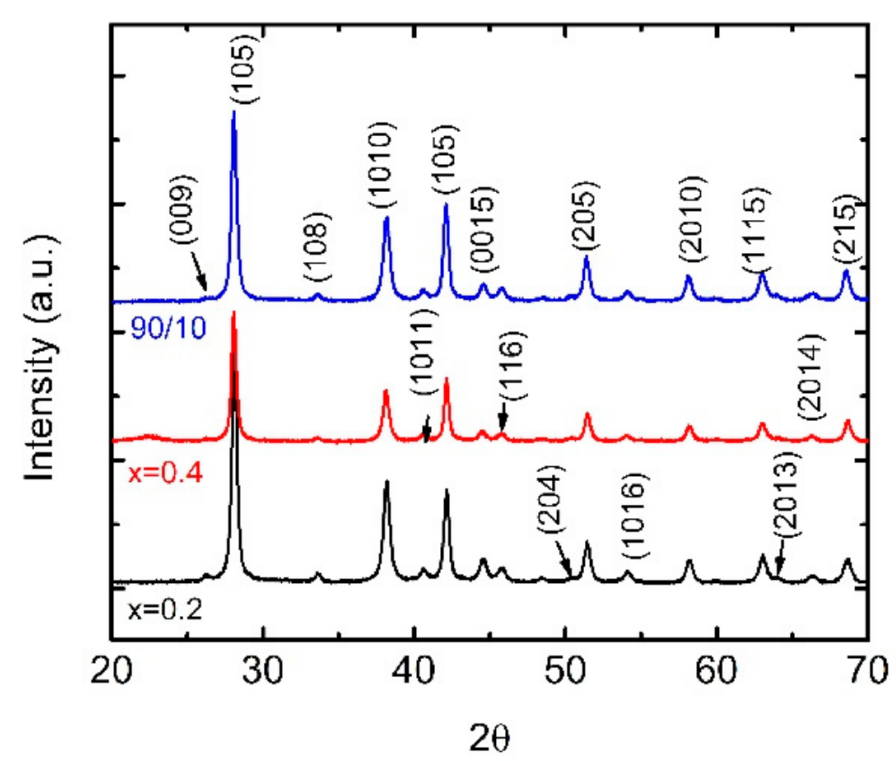
Figure 2. X-ray diffraction (XRD) patterns for x = 0.2 (black line) and x = 0.4 (red line) BST/Acrylonitrile Butadiene Styrene (ABS) blends (x = 0.4)/ABS blend with m BST presented for all three spectra, for